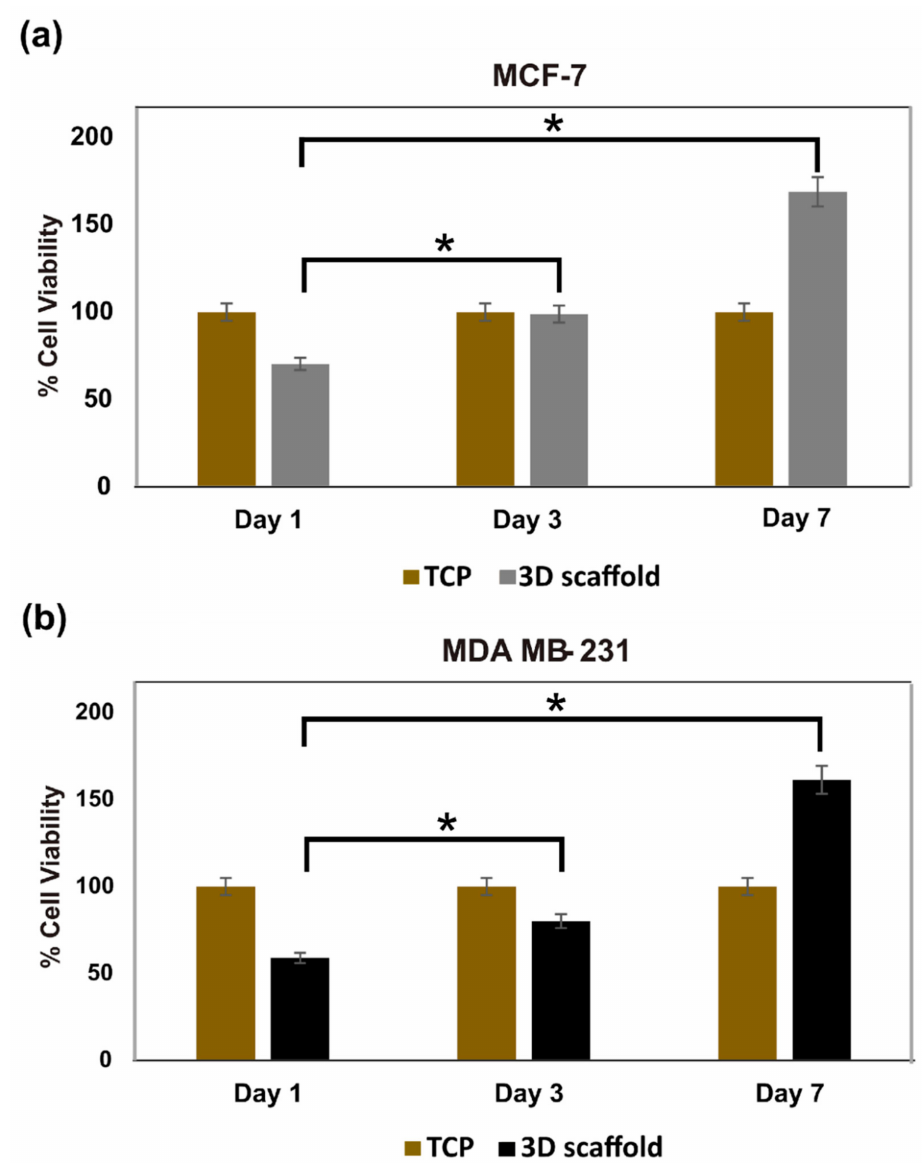
Figure 4. Alamar blue assay of ( a ) MCF-7 cells and ( b ) MDA-MB-231 cells cultured on 2D tissue culture plastic (TCP) and 3D PHA scaffold for 1, 3 and 7 days. Differences were considered statistically significant with p < 0.05